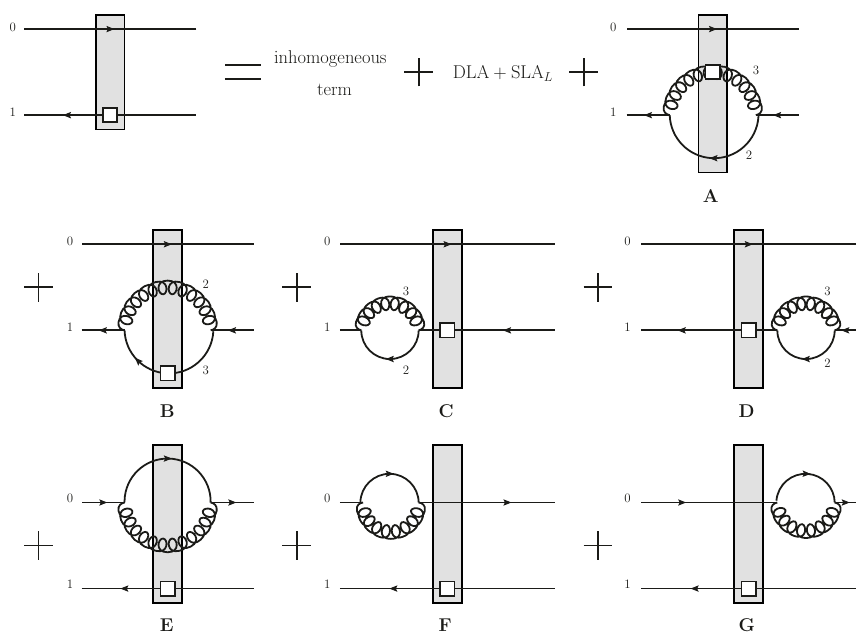
Figure 4 . Diagrams for SLA T splittings of a polarized fundamental dipole. For brevity, the inhomogeneous term (the initial condition) and the DLA+SLA